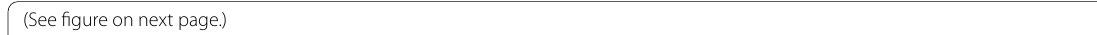
(See figure on next page.) Fig. 8 Two different cases: a case of right breast cancer post-conservative surgery and operative bed positive surgical margins. a Digital mammogram of both breasts MLO and CC views that demonstrated dense breasts and BI-RADS zero category of the mammogram. b CEM of the same views that showed operative bed numerous enhancing foci centered on the scar of the operative bed (circle) suggestive of recurrent carcinoma. The second case is a 53-year-old with pathologically proved triple negative invasive ductal carcinoma grade II. c Axial post-contrast MR imaging before chemotherapy that showed left breast enhancing mass (circle- proved carcinoma) and ipsilateral pathologically enlarged likely infiltrated axillary node (arrow). d Post-completion of the neo-adjuvant chemotherapy post-contrast MR image where there is almost complete resolution of the left breast carcinoma (arrow) and marked regression of the size of the ipsilateral lymph nodes